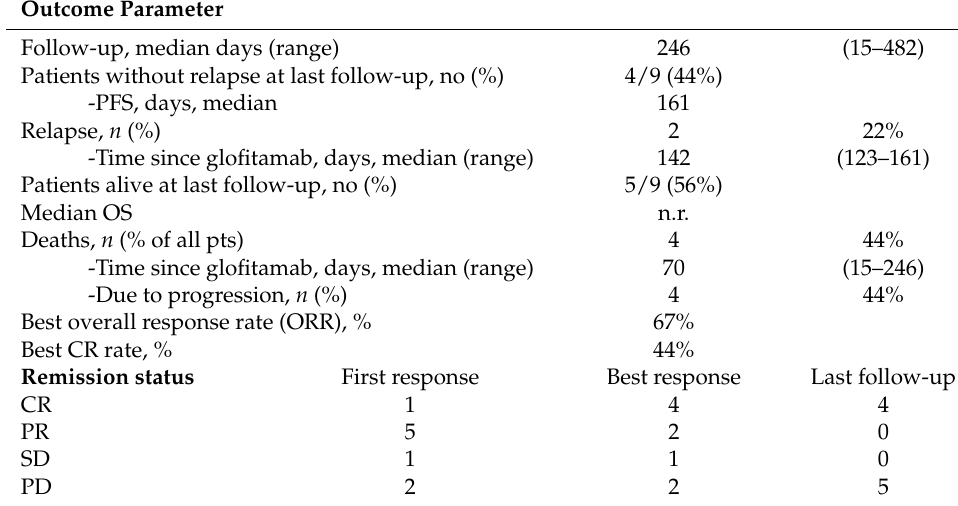
Table 4. Outcomes of Glofitamab